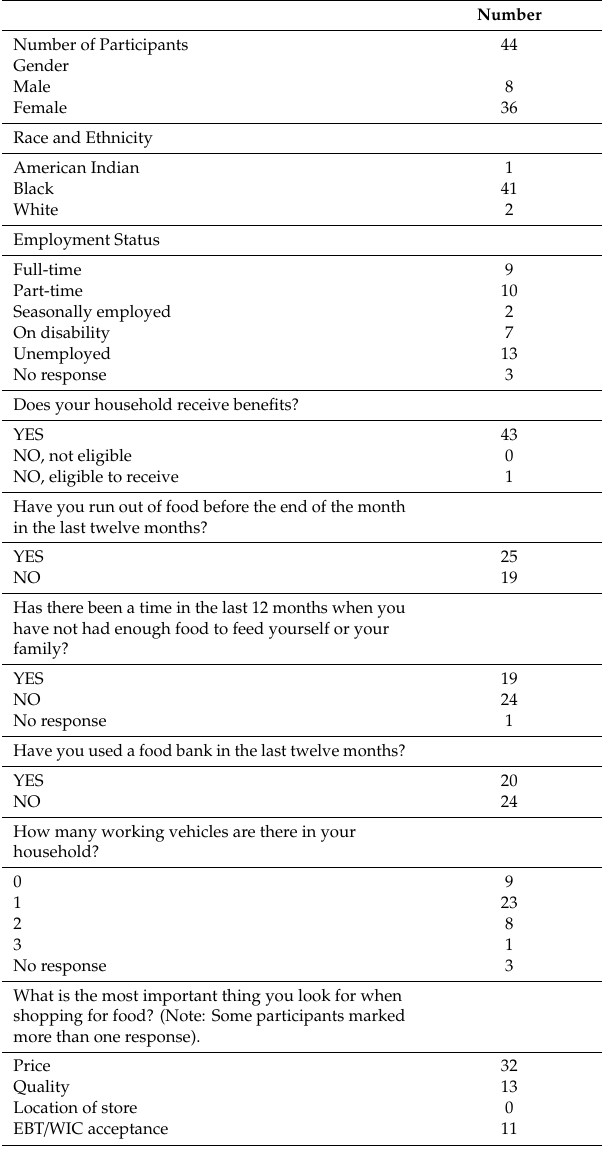
Table 2. Focus Group Participant